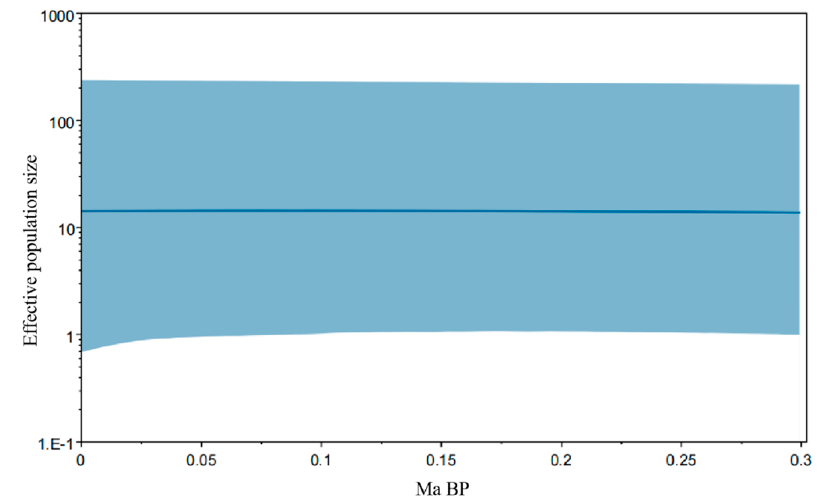
Figure 6. Bayesian skyline plot of C. alburnus.